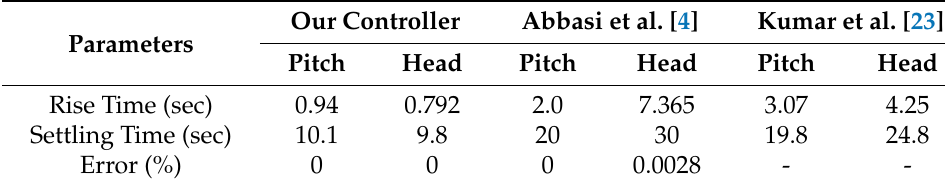
Table 8. Comparison of results with state-of-the-art.